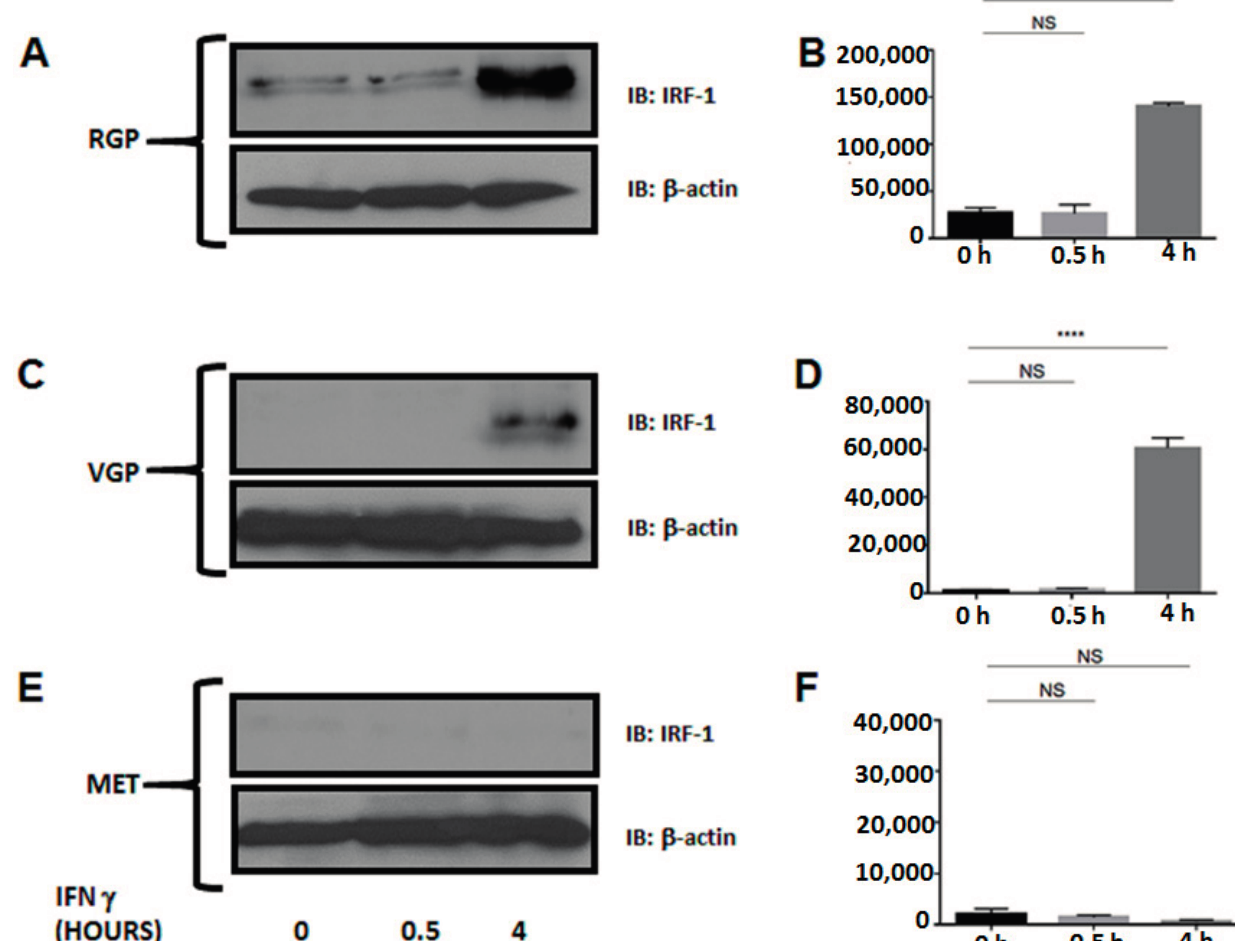
Figure 5. Western blot analysis of IRF-1 expression. Cells were stimulated with IFN- γ for 0, 0.5 or 4 h. Lysates were cleared of cellular debris, and equal concentrations of protein were separated via SDS-PAGE. Proteins were identified by incubating nitrocellulose with antibodies against IRF-1 (RGP, VGP, MET; top ). β -Actin was used as a loading control (RGP, VGP, MET; bottom ). ( A , B ) IRF-1 is expressed in RGP cells following four hours of IFN- γ stimulation; ( C , D ) In VGP cells, IRF-1 is expressed to a greater extent after four hours of stimulation, compared to RGP; ( E , F ) MET cells lack IRF-1 expression following 4 h of IFN- γ stimulation. y -axes ( B , D , F ) represent Total Pixels (Quantification of A , C , E ). NS: Not Significant; **** p <